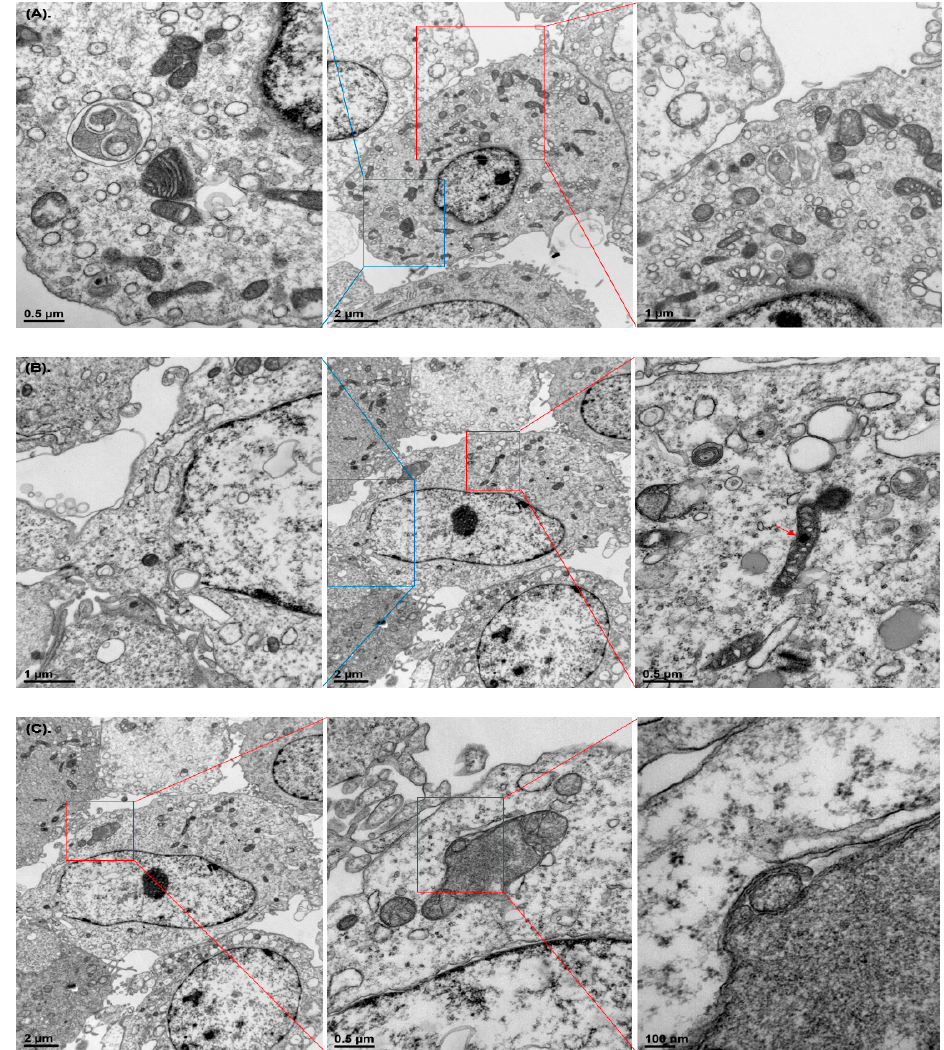
Figure 3. Overview of changes in intracellular structures of WCSC-treated cells. Astrocytes were incubated with 1% WCSC for 24 h, and TEM was used to observe changes in intracellular structures: ( A ) we can find autolysosome-like vacuoles (a blue square) and various sizes of mitochondria (a red square); ( B ) damage of the nuclear membrane (a blue square) and localization of WCSC components into the mitochondria (a red square, a red arrow); ( C ) mitophagy.